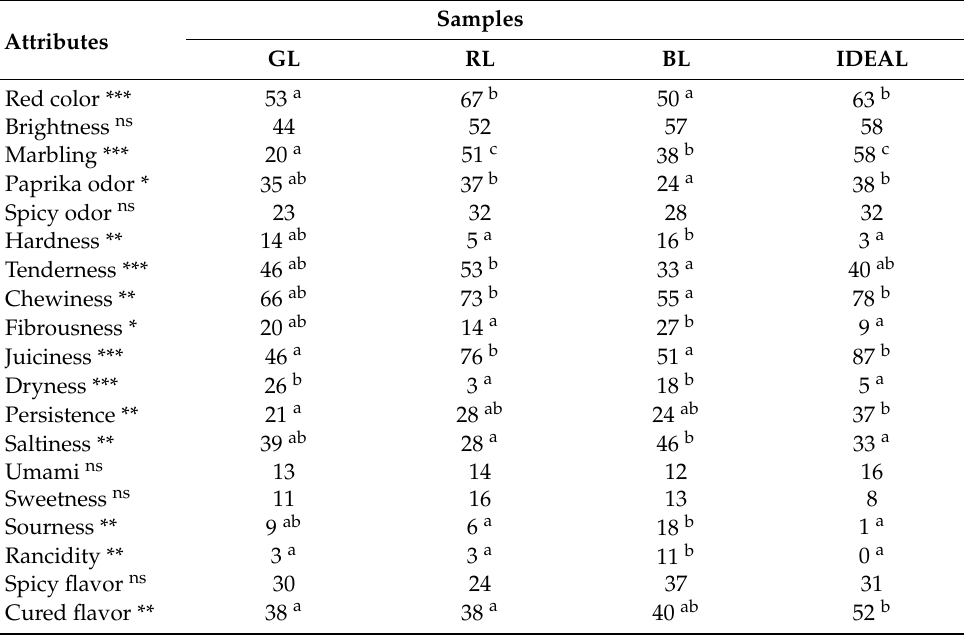
Table 2. Frequency of mention (%) of each attribute by consumers using CATA questionnaires for the three commercial categories of dry-cured loins and ideal product.